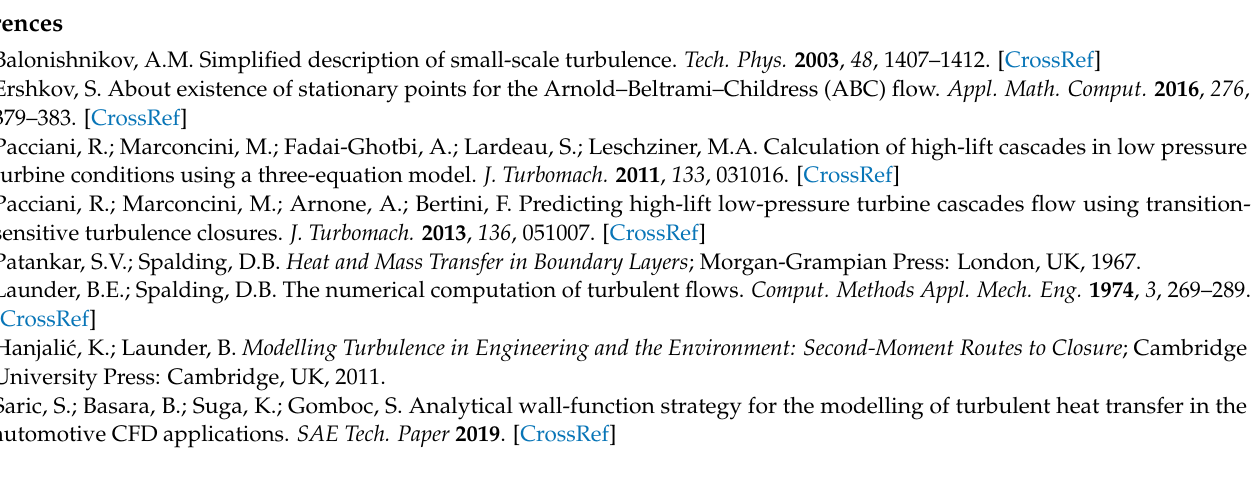
Figure 7. Mean velocity profile of T3A plotted in wall units in the fully turbulent zone.